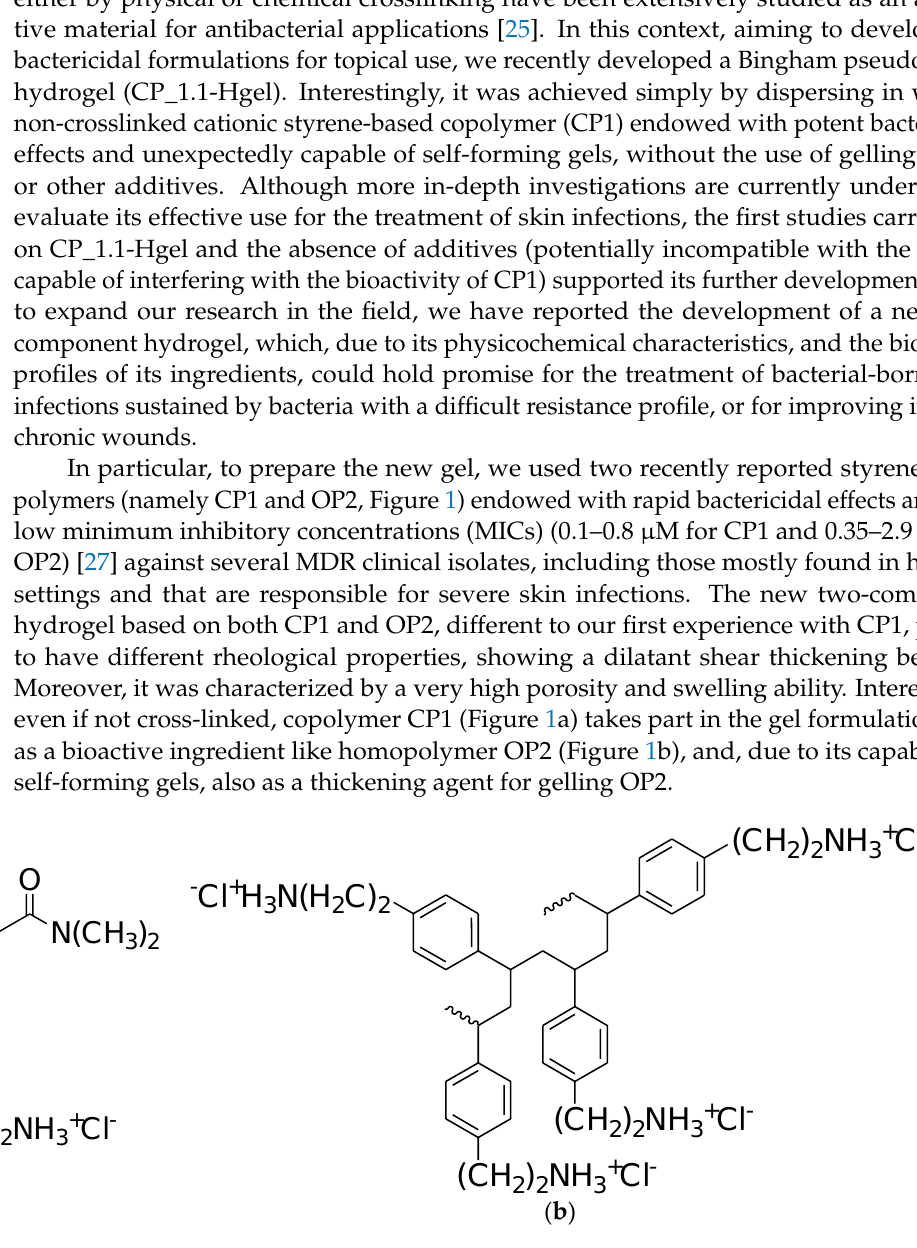
Figure 1. Chemical structure of CP1 ( a ) and OP2 ( b ).